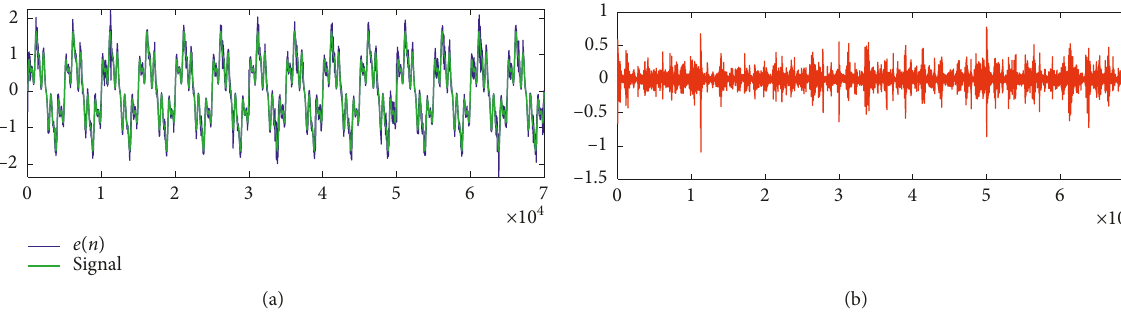
n . (b) Residual noise. ( )